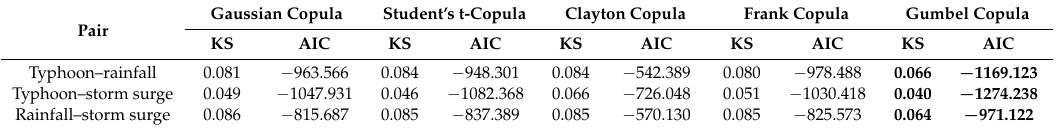
Table 6. Fitting results of bivariate distribution functions. AIC, Akaike information